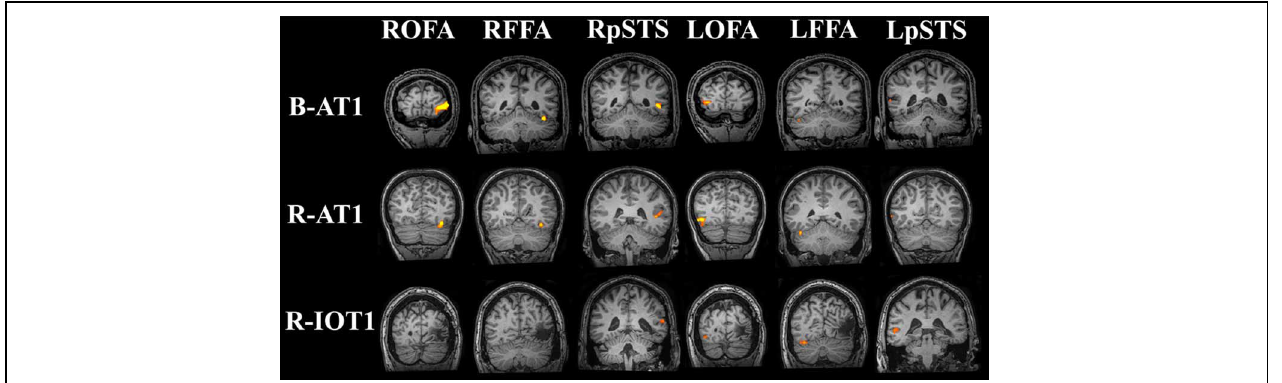
lesion, R-IOT1 does not display a right OFA or right FFA. However, a right posterior STS (pSTS) was identified along with all three core regions in the left hemisphere.